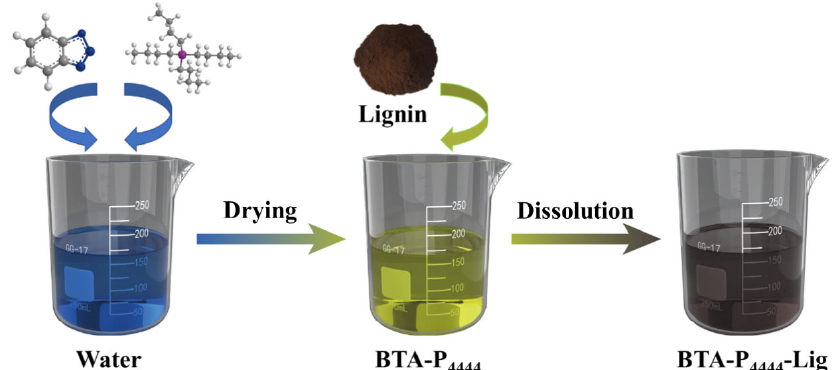
Fig. 1 Synthesis process and molecular mechanism of BTA-P 4444